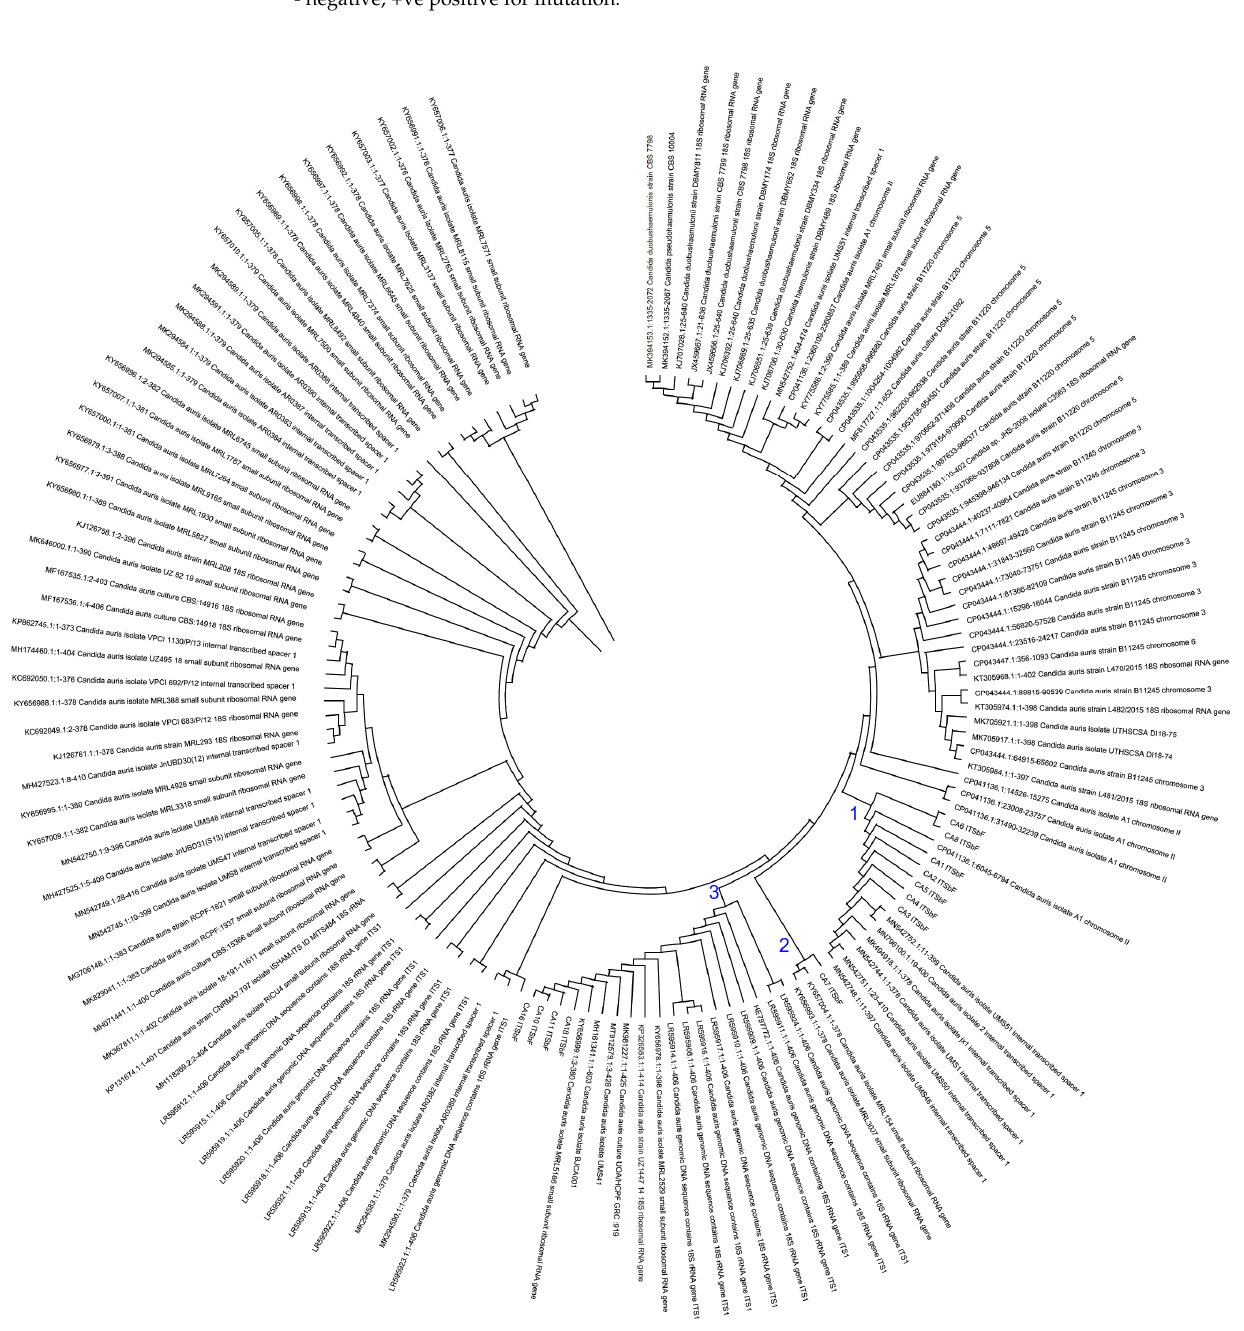
Figure 2. ITS sequenced based phylogenetic analysis of the Candida auris isolates. The blue-colored numbers indicate the three clades of the Candida auris isolates. Phylogenetics tree using ITS sequence constructed using MEGA11.